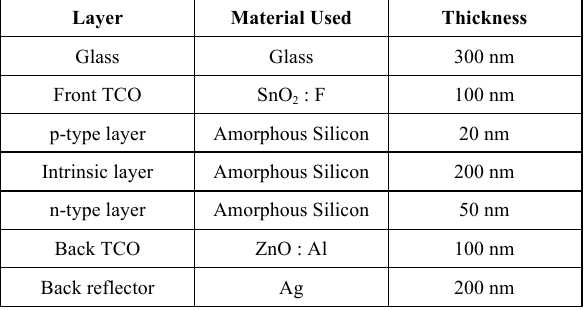
NAME OF THE L AYERS , MATERIALS & THICKNESS OF THE LAYERS